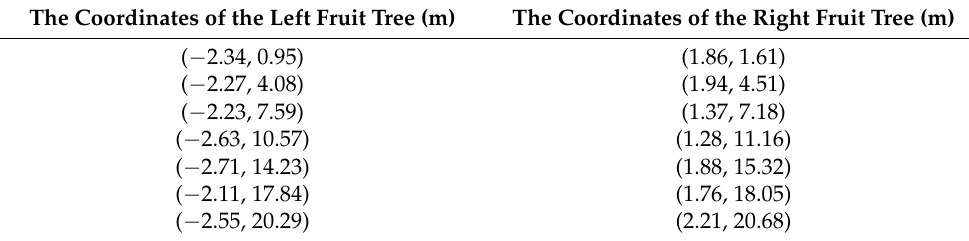
Table 4. Two-dimensional LiDAR sensor parameters. The Coordinates of the Left Fruit Tree